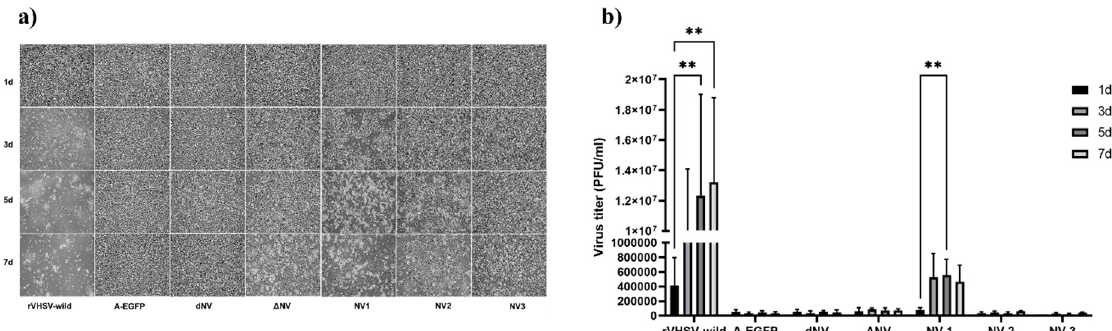
Figure 2. ( a ) CPE progression in EPC cells infected with rVHSV-wild, rVHSV-A-EGFP (A-EGFP), rVHSV-dNV (dNV), rVHSV- Δ NV ( Δ NV), rVHSV-NV1 (NV1), rVHSV-NV2 (NV2), or rVHSV-NV3 (NV3) at MOI 0.1. ( b ) At 1-, 3-, 5-, and 7-days post-infection, we analyzed the growth of each virus using plaque assay (n = 3, means ± SD, ** p < 0.01).